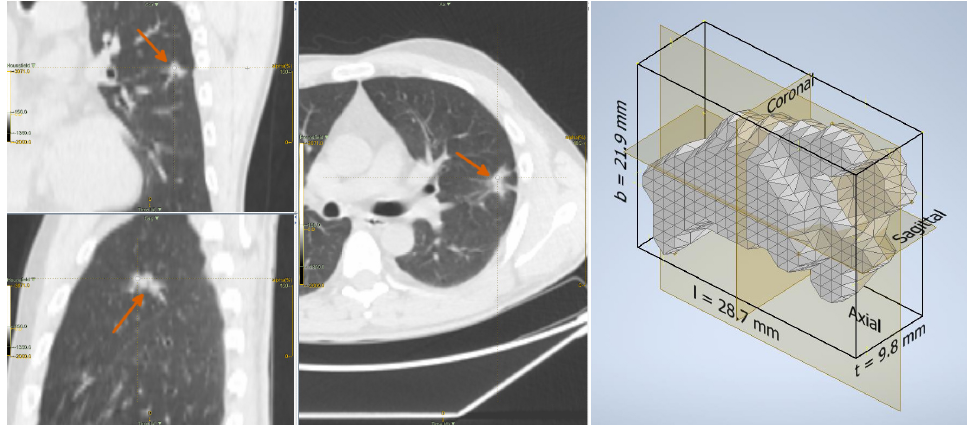
Figure 3. Fibrosis in a 46-year-old man: lesion on the CT scan ( left ) and the reconstructed three- dimensional volume within the axis-aligned bounding box ( right